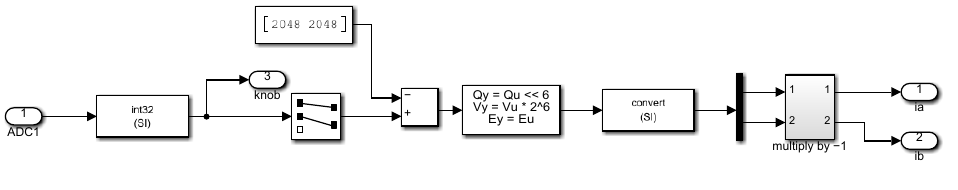
Figure 4. Current acquisition model.